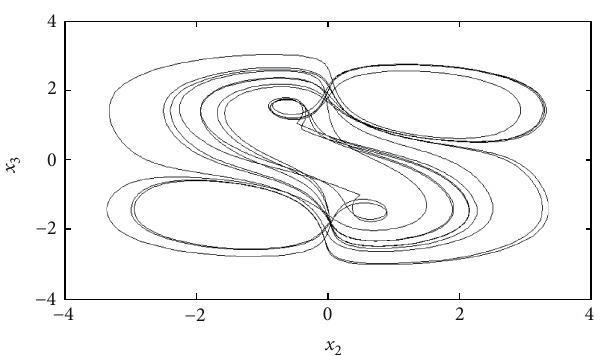
Figure 5: Coexisting two kinds of three-scroll chaotic attractors with initial in fractional-order memristive system (2) for 𝑞 = 0.965 . conditions (±0.2, ±0.1, ±0.1)